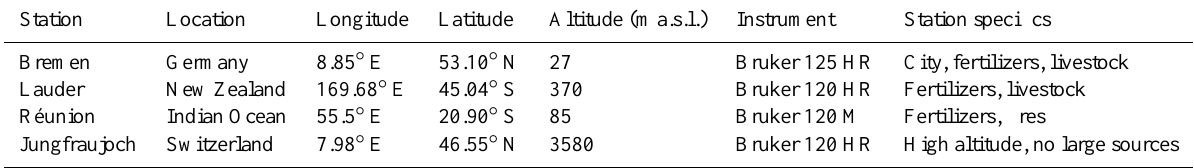
Table 1. FTIR stations used in the analysis. The location, longitude, latitude and altitude are given for each station as well as the instrument used for the measurements. Some station specifics are given in the last column.